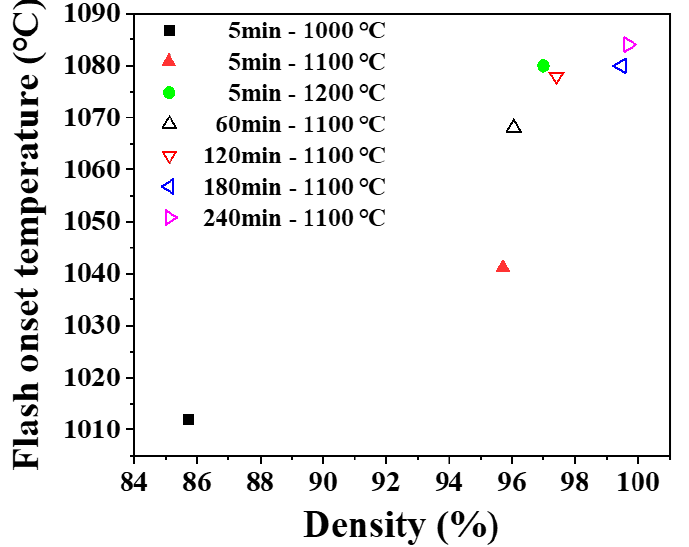
Figure 5. Change of flash onset temperature with a density of presintered sample. Legend shows presintering condition.